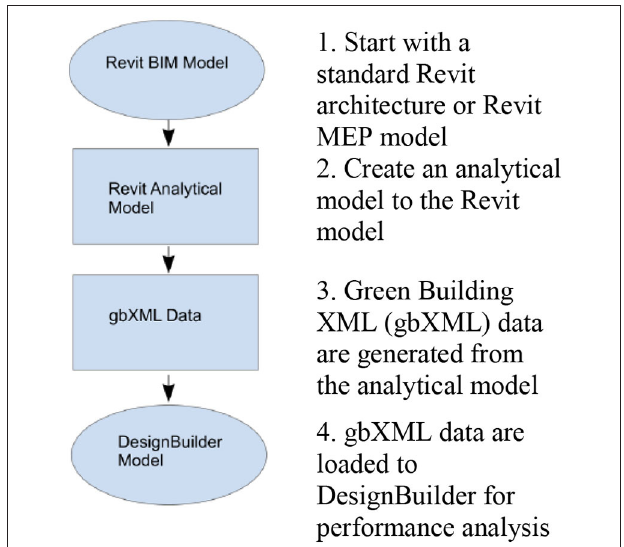
FIGURE 7 | Data diagram for the Revit to DesignBuilder transition ( DesignBuilder Revit–gbXML Tutorial,